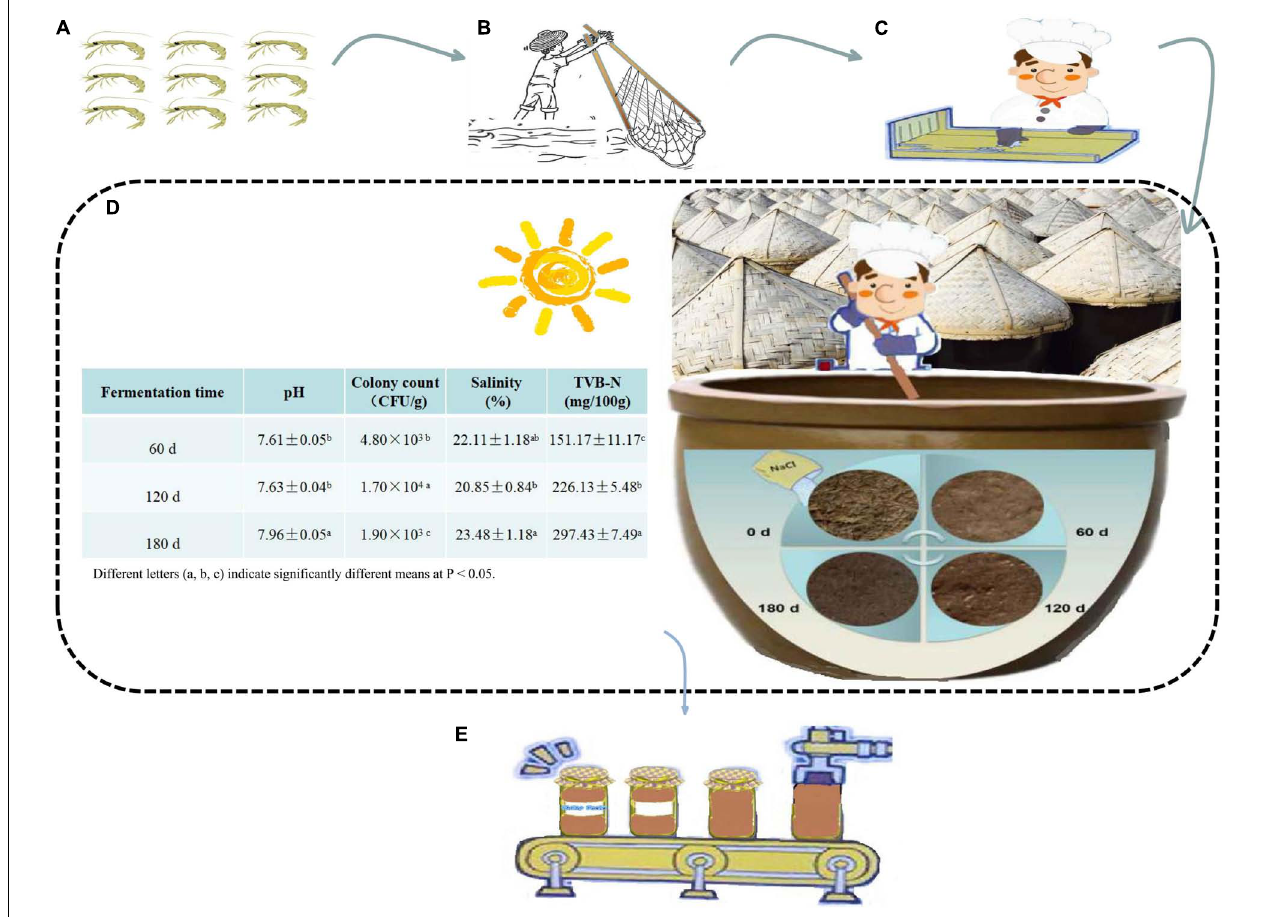
FIGURE 1 | The fermentation process of grasshopper sub shrimp paste. (A) Grasshopper sub shrimp, (B) Catching grasshopper sub shrimp, (C) Screening process to remove the impurities, (D) Natural fermentation and changes in physicochemical and microbial indexes during fermentation, (E)